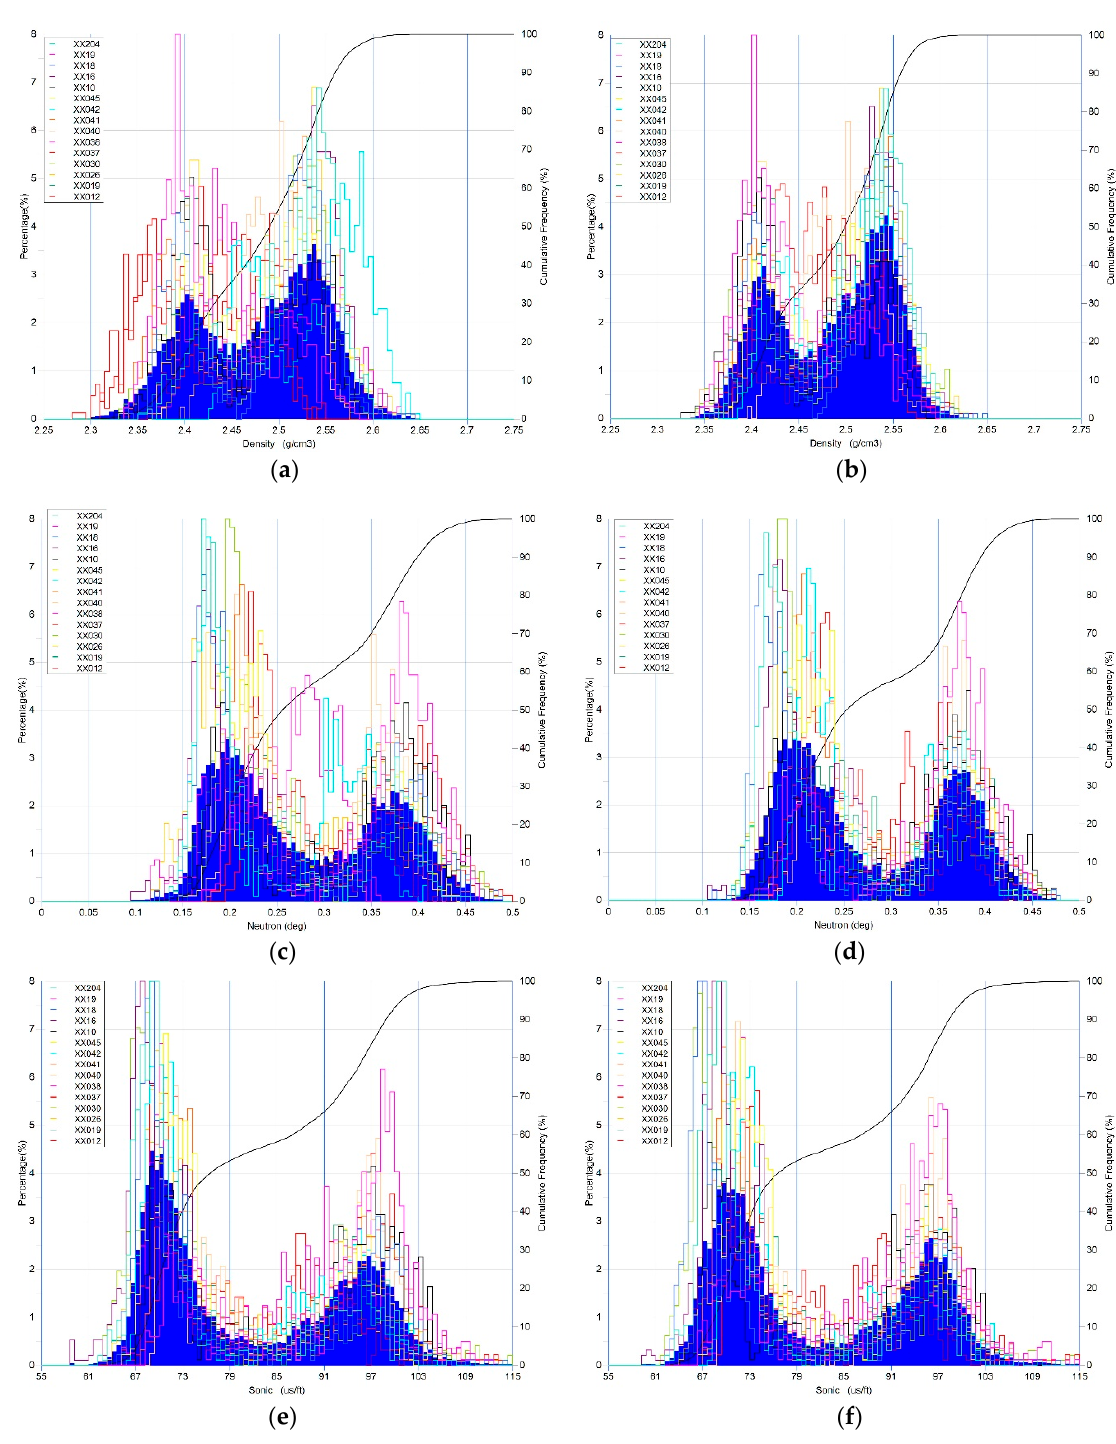
Figure 6. Comparisons of histograms before and after normalization: ( a ) Multi-well density before normalization; ( b ) Multi-well density after normalization; ( c ) Multi-well neutron before normalization; ( d ) Multi-well neutron after normalization; ( e ) Multi-well acoustic before normalization; ( f ) Multi-well acoustic after normalization.